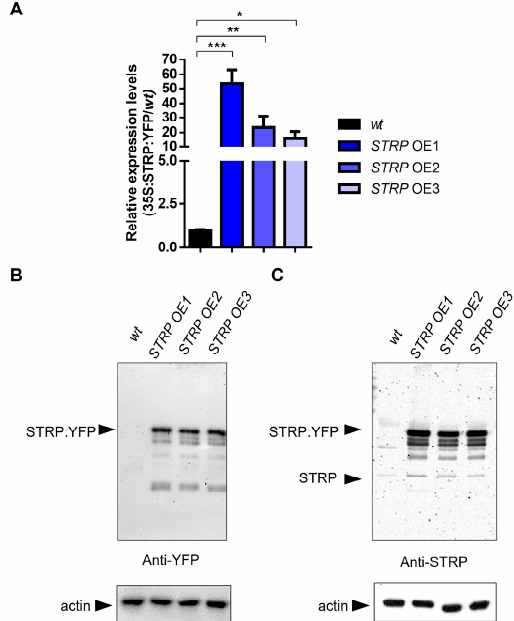
Figure 2. STRP overexpression and protein levels in transgenic lines. STRP overexpression and protein levels were assessed on wt, STRP –overexpressing 1 (OE1), OE2, and OE3 seedlings grown for two weeks on MS medium. ( A ) STRP overexpression was determined on total RNA extracted from A. thaliana , retrotranscribed, and analyzed by RT-qPCR. Error bars are s.e.m. of three independent experiments. * p < 0.05, ** p < 0.01, *** p < 0.001, by Student’s t -test. STRP levels in wt plants and the three OE lines were determined by Western blot using 20 µg of whole cellular extract. STRP was detected by incubating the membrane with anti-YFP ( B ) and anti-STRP ( C ) antibodies. Actin was used as a loading control.